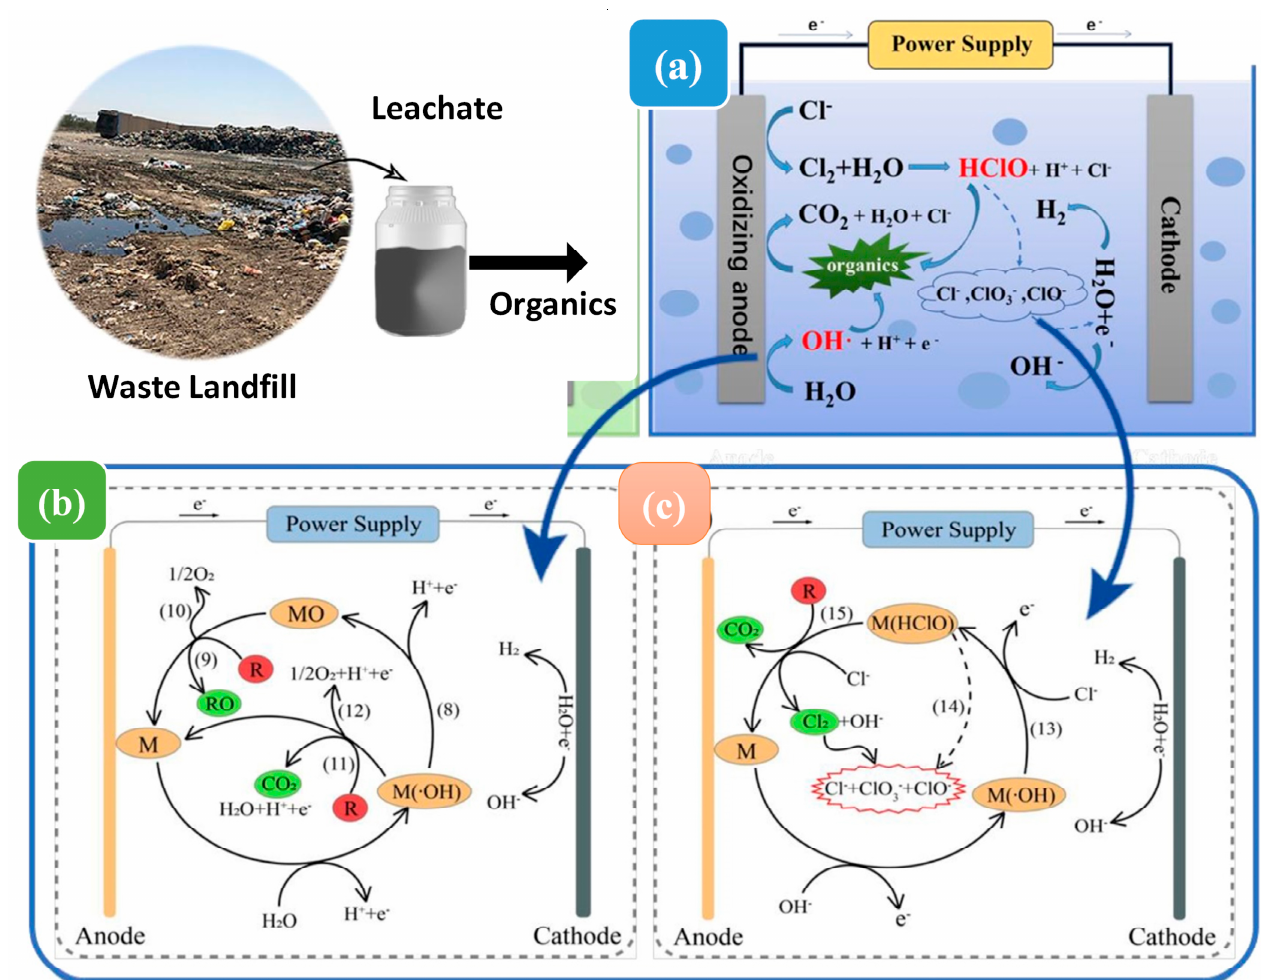
Figure 3. Electrochemical oxidation mechanism. ( a ) hydroxyl radical-mediated indirect oxidation ( b ), active chlorine-mediated indirect oxidation ( c ) (modified and acquired from [72].